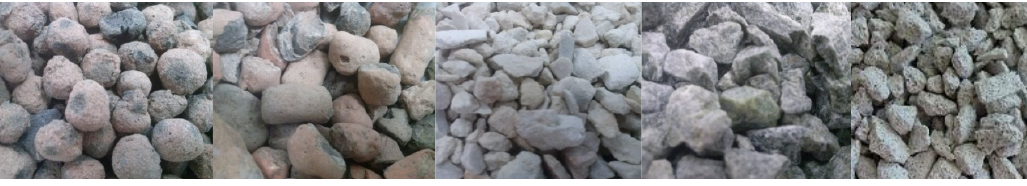
Figure 1. Drainage materials tested in the study, from the left: Pollytag ® , lightweight expanded clay aggregate (LECA), chalcedony, serpentynite and autoclaved aerated concrete